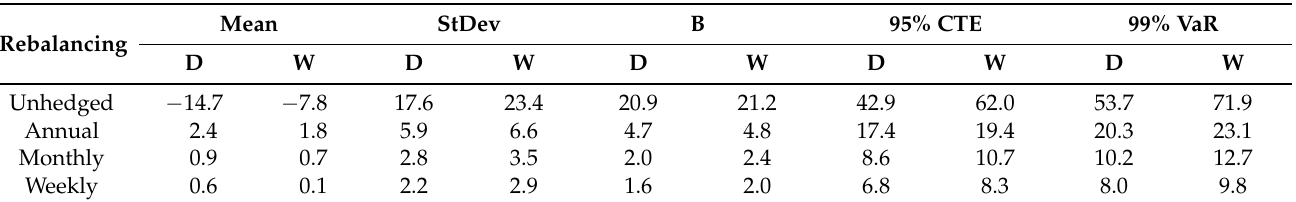
Table 3. Risk measures for the insurer’s net loss at maturity based on daily and weekly RS-GARCH models with parameter